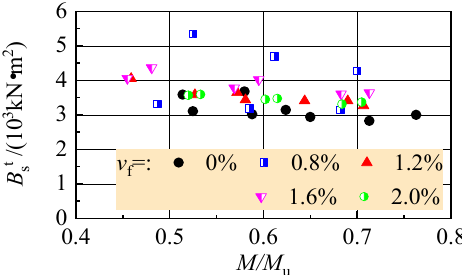
Figure 14. Tested flexural sti ff ness changed with moment of the test beams.